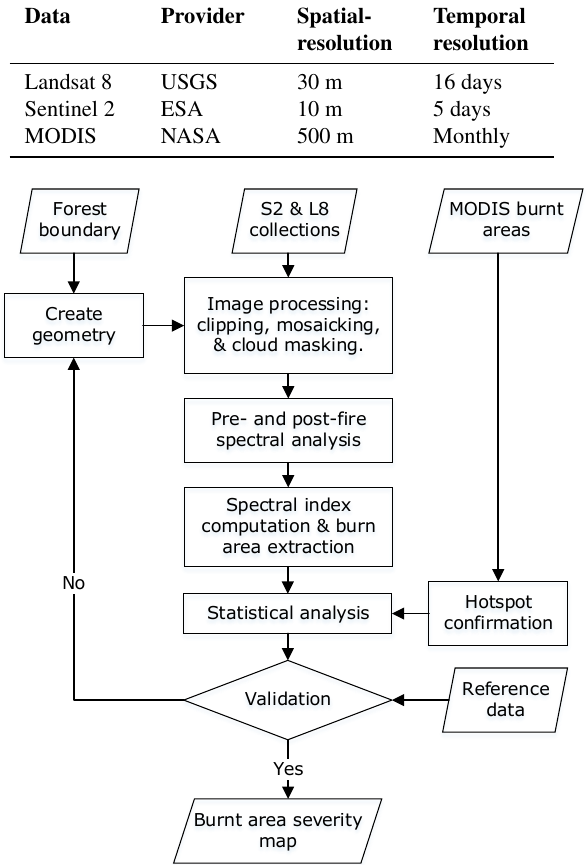
Figure 2. Methodological framework adopted to detect small ex- tent fires using